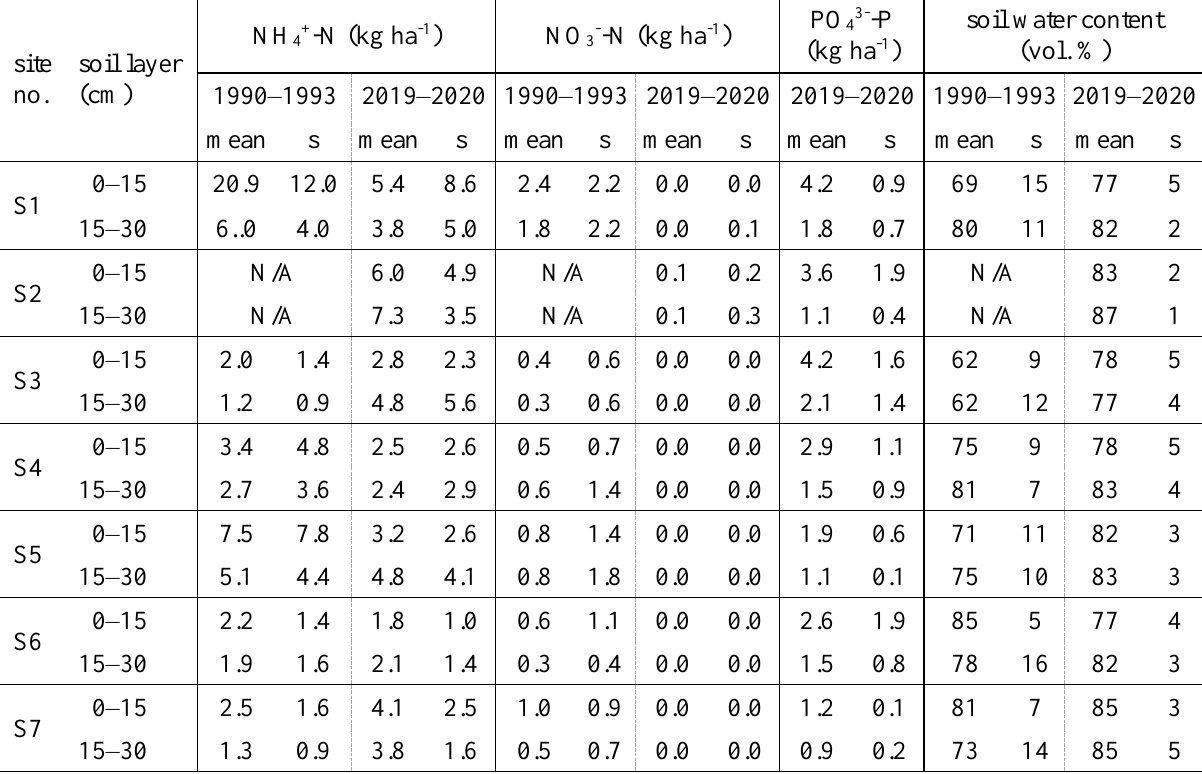
Table A4. Soil properties at the individual sampling sites, from the initial examination in 1990–1993 (Gebhardt & Knabke 1994) and the follow-up examination in 2019–2020. N/A = data not